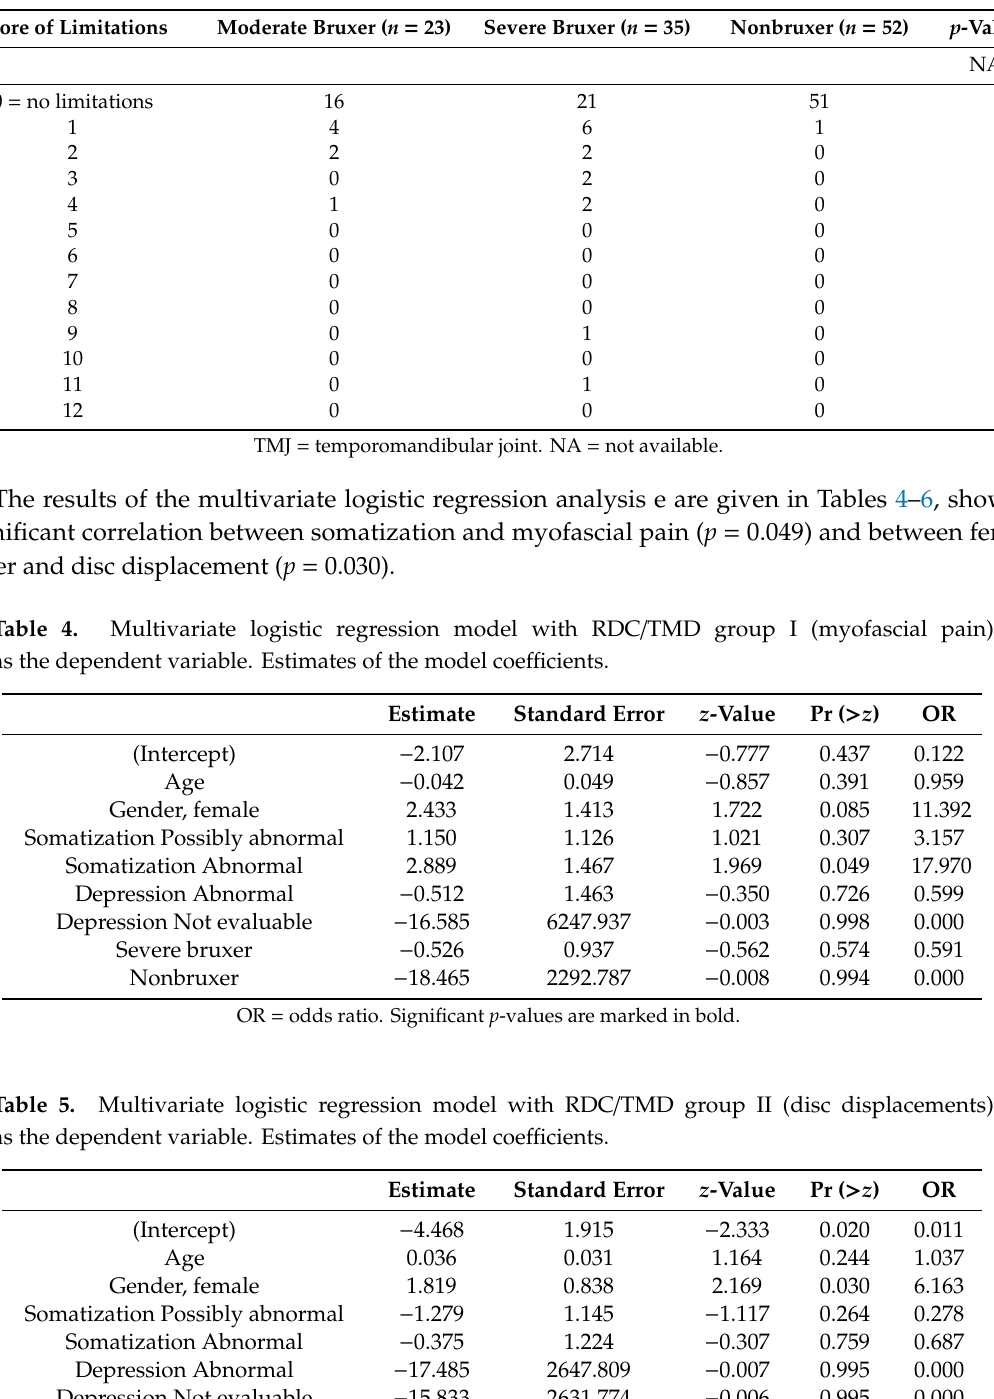
Table 3. Self-reported limitations caused by problems with the TMJ or muscles (12 items from the jaw disability index).